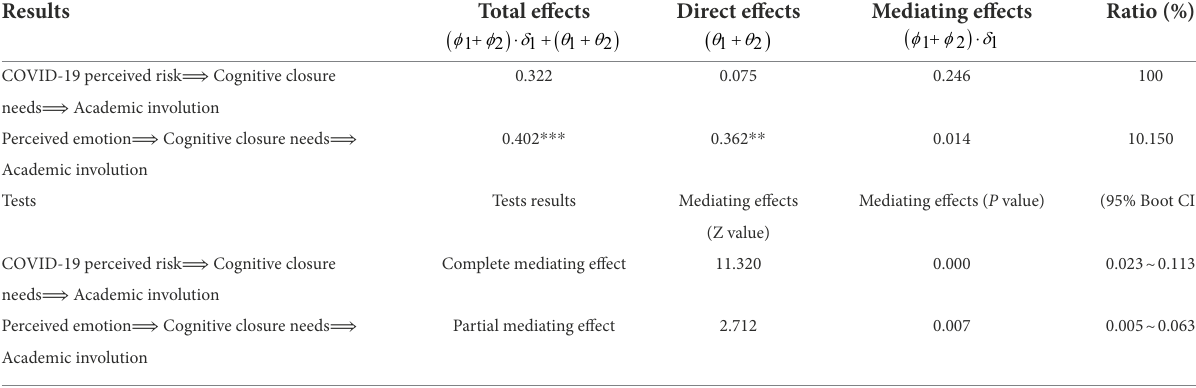
TABLE 3 Mediating effect results and